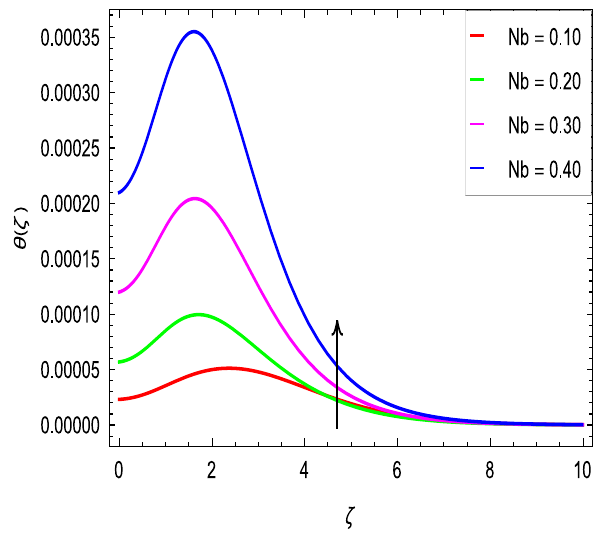
Figure 16. θ(ζ) in terms of Nb .